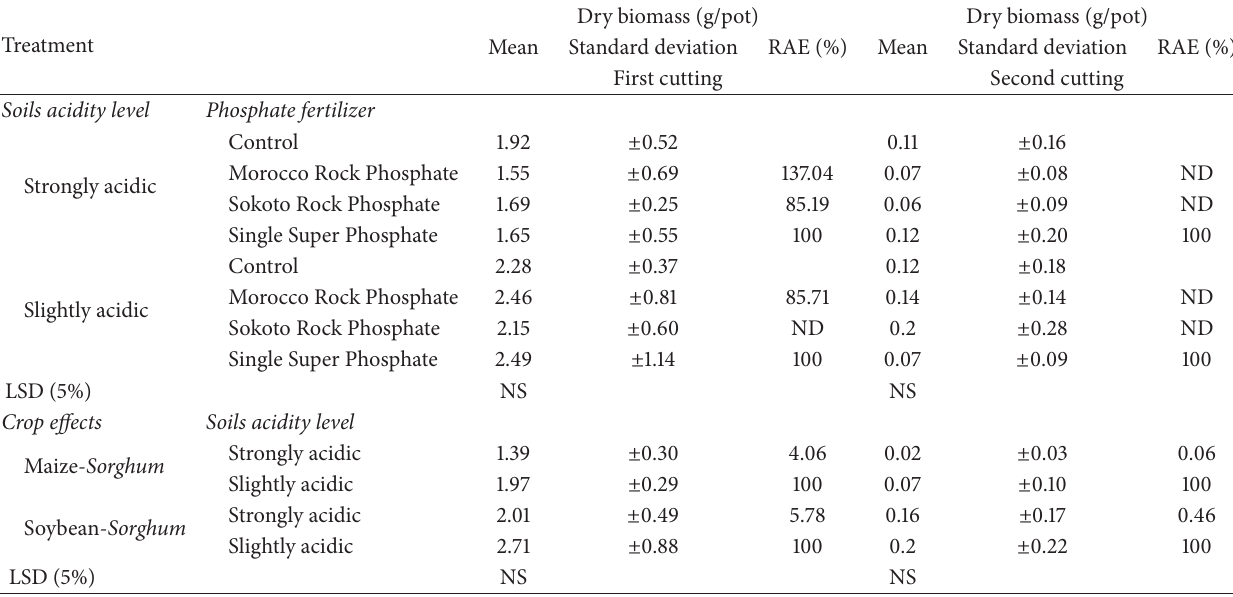
Table 7: Influence of the experimental soils and P-source or crop effects and soils on dry biomass yield (g/pot) of Sorghum plants in the second cropping.